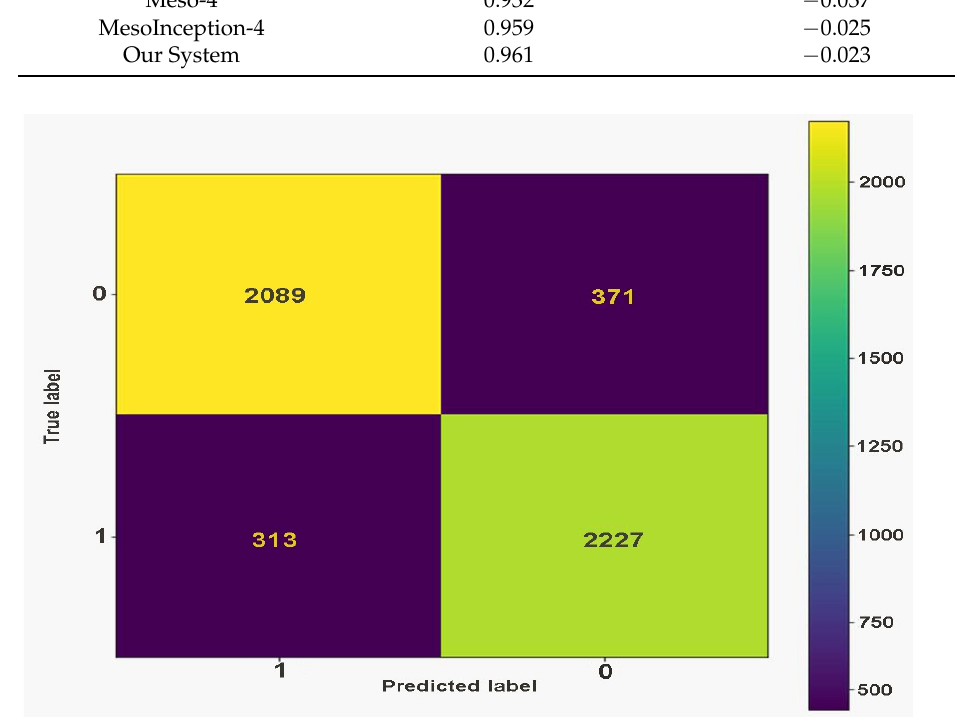
Figure 12. Confusion matrix of our system (tn = 2089, fp = 371, fn = 313 tp = 2227). The comparison of the proposed model with other cutting-edge state-of-the-art models were presented in Table 8 and Figure 13. The proposed model outperforms other models in terms of accuracy and F1-Measure with 0.8632 and 0.8669, respectively. The authors of [9] have a better performance in terms of recall metric with 0.9723, while the authors of [54] have a higher performance in terms of precision with 0.8724. Overall, the proposed model performs better when compared with other baseline models. This shows that the proposed CNN + ReLU model can be used to classify a DeepFake video with better accuracy. Table 8. Performance evaluation in contrast to other cutting-edge techniques in DeepFake